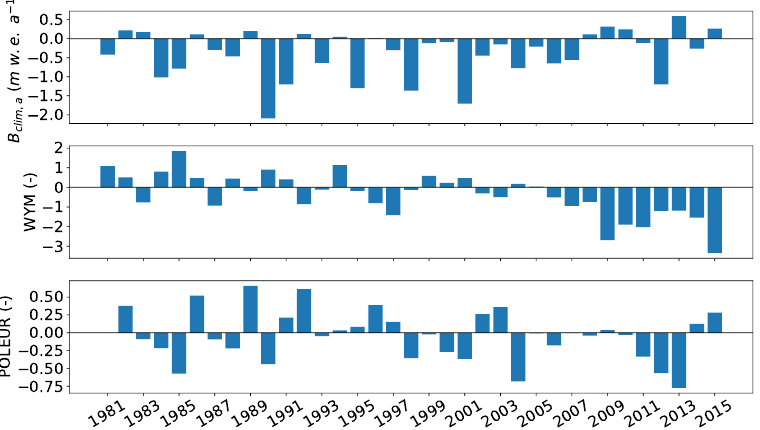
Figure 10. Annual glacier-wide climatic mass balance (1982-2015) of the Halji glacier (upper panel), Webster and Yang Monsoon index (WYM, middle panel) and Polar/Eurasia index (POL, lower